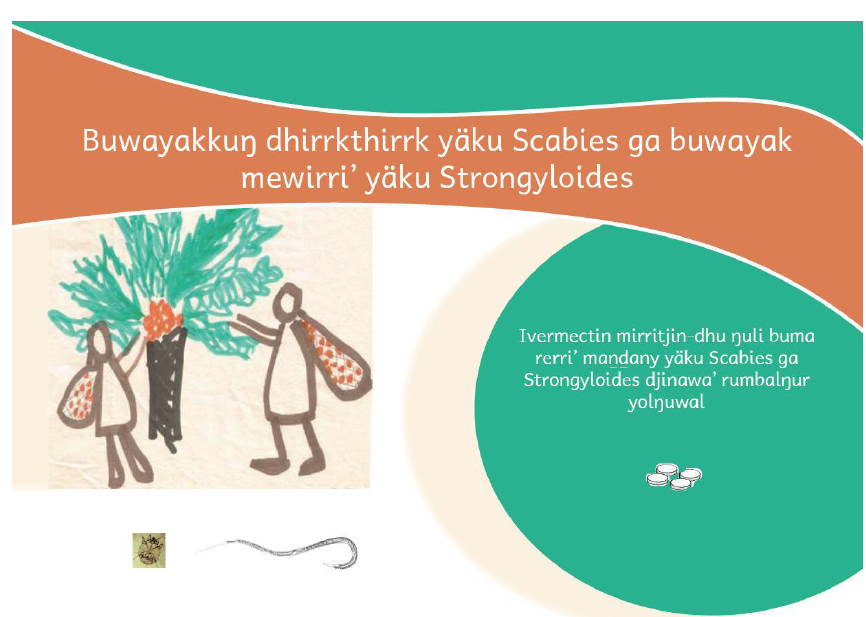
Figure 1. Title page of the flipchart. The title translates as ‘Eliminating scabies mites and invisible Strongyloides worms’. The subtitle: ‘Ivermectin medicine kills both diseases in people’s bodies’. The title page includes symbols of the main components of the story: the overall analogy (the cycad story), a scabies mite, an adult female Strongyloides worm, and the ivermectin tablets.